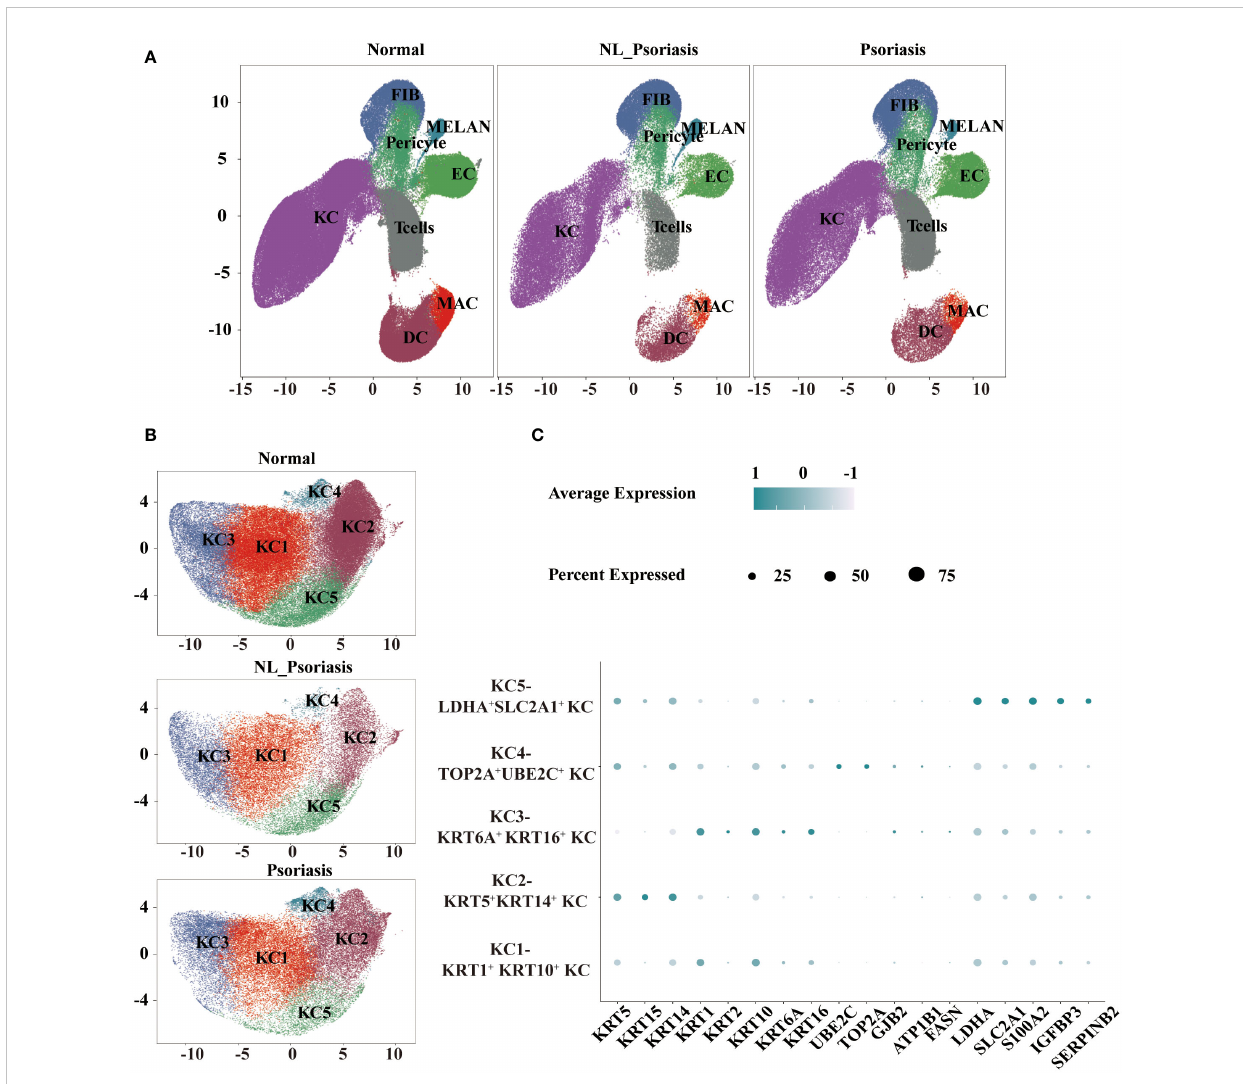
FIGURE 2 Single-cell landscape of normal and psoriasis human skin. (A) UMAP visualization of eight cell types. (B) UMAP representation of fi ve clusters of keratinocytes. (C) A dot plot displaying critical marker transcripts used to distinguish keratinocytes. UMAP, Uniform manifold approximation and